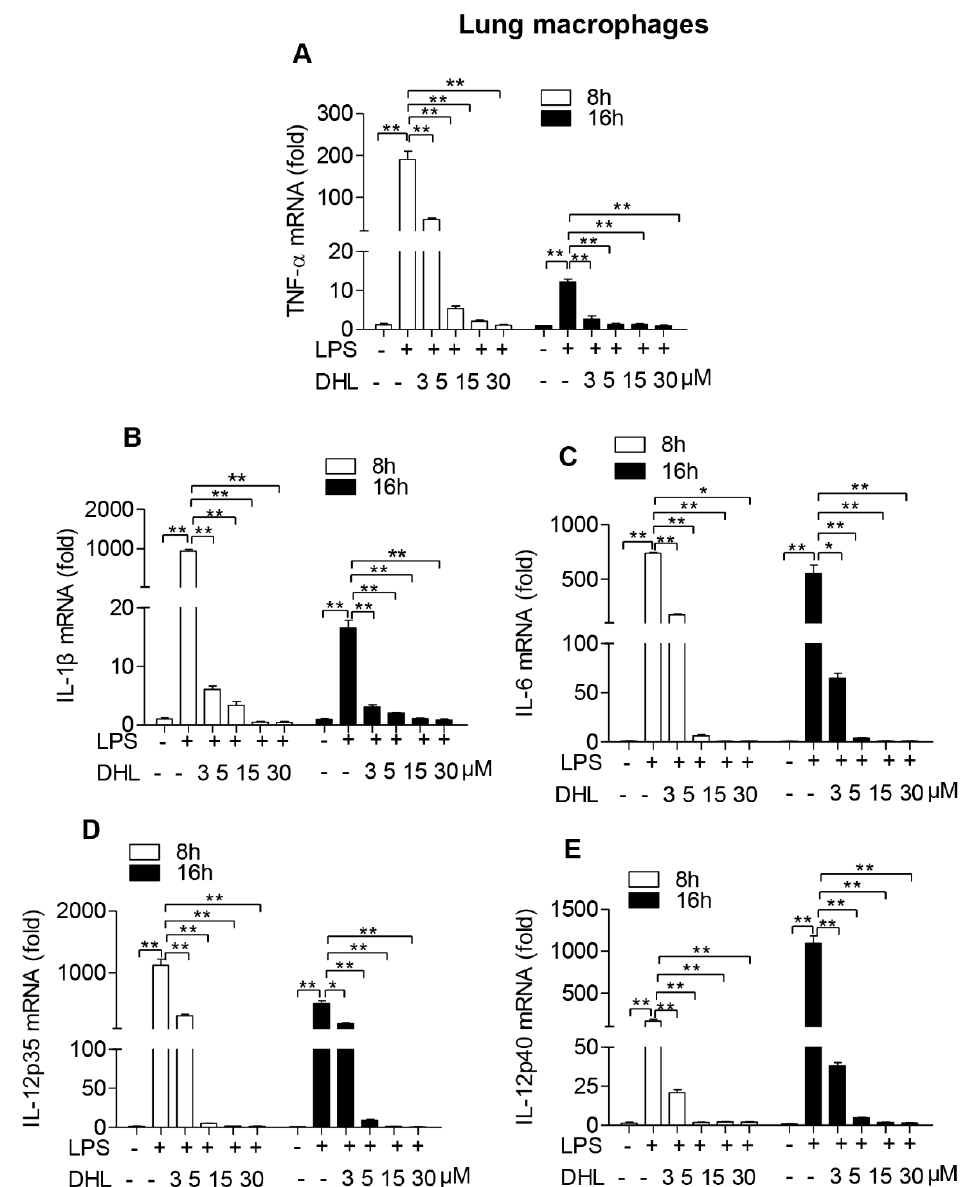
Figure 4. DHL decreased proinflammatory cytokines production in LPS-stimulated lung macrophages. Lung macrophages were pre-treated with 0, 3, 5, 10 and 30 μ mol/L DHL for 0.5 h before LPS stimulation (100 ng/mL) for 24 h, cells were collected to isolate total RNAs, the mRNA expression level of ( A )TNF- α , ( B ) IL-1 β , ( C ) IL-6, ( D ) IL-12 p35 and ( E ) IL-12 p40 were measured by quantitative PCR respectively. Values represent means ± SEM, * p < 0.05 and ** p < 0.01.